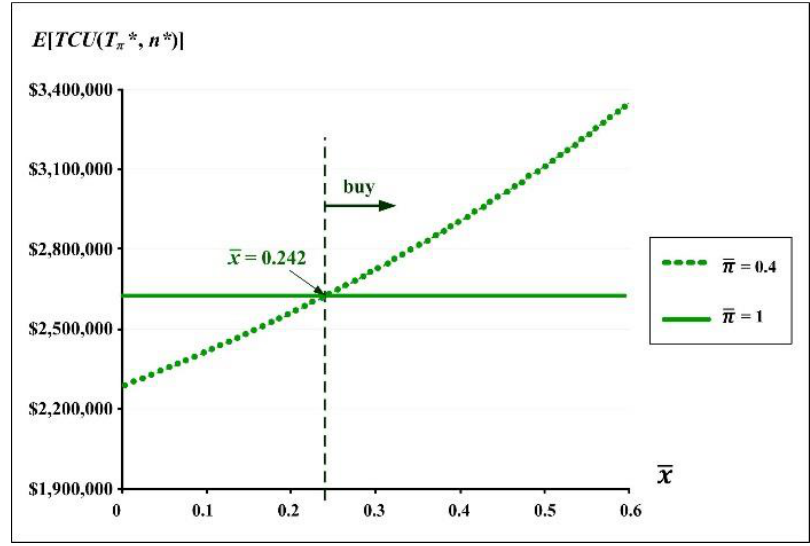
Figure 8. Effect of differences in x on management’s make-or-buy decision